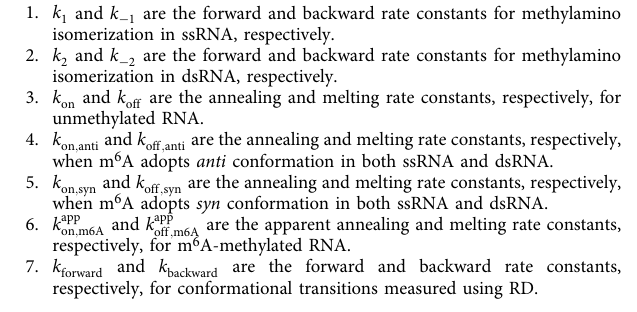
Table 8) extension 54 using 13 C/ 15 N isotopically labeled dNTPs (Silantes), and puri fi ed using 20% 29:1 polyacrylamide denaturing gel with 8M urea, 20mM Tris borate, and 1mM EDTA, and electroelution (Whatmann, GE Healthcare) in 40 mM Tris acetate and 1 mM EDTA. DNA duplexes were prepared and buffer exchanged in a manner analogous to that described above for RNA